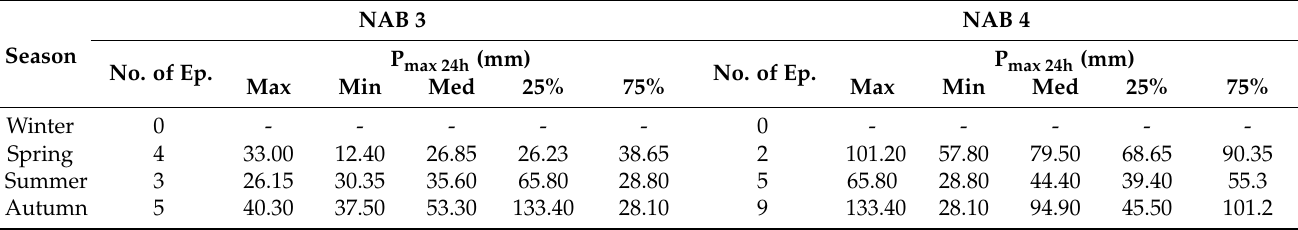
Table 2. Seasonal distribution of episodes with the most impact in Barcelona based on the reported incidents from April 2013 to December 2018. The seasons considered were winter (December, January, and February), spring (May, April, and March), summer (June, July, and August) and autumn (September, October, and November). The values shown are the number of episodes for each category (NAB equal to 3 or 4) per season, observed maximum, minimum and median values for maximum cumulated precipitation in an episode for each season, and 25 and 75 percentiles for the same variable for each